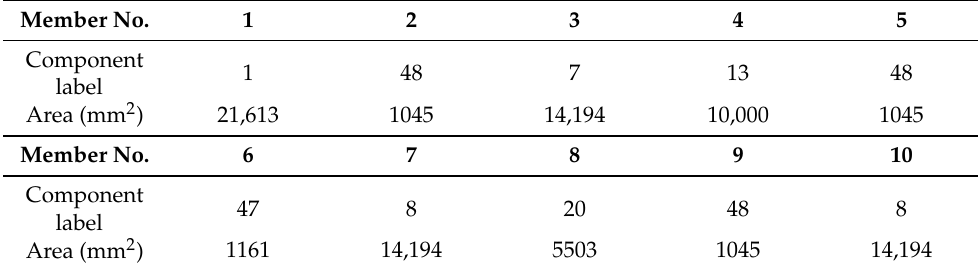
Table 1. The results of 7th analysis for M ( X ) ≈ weight ( X ) = 2492 kg. Member No. 1 2 3 4